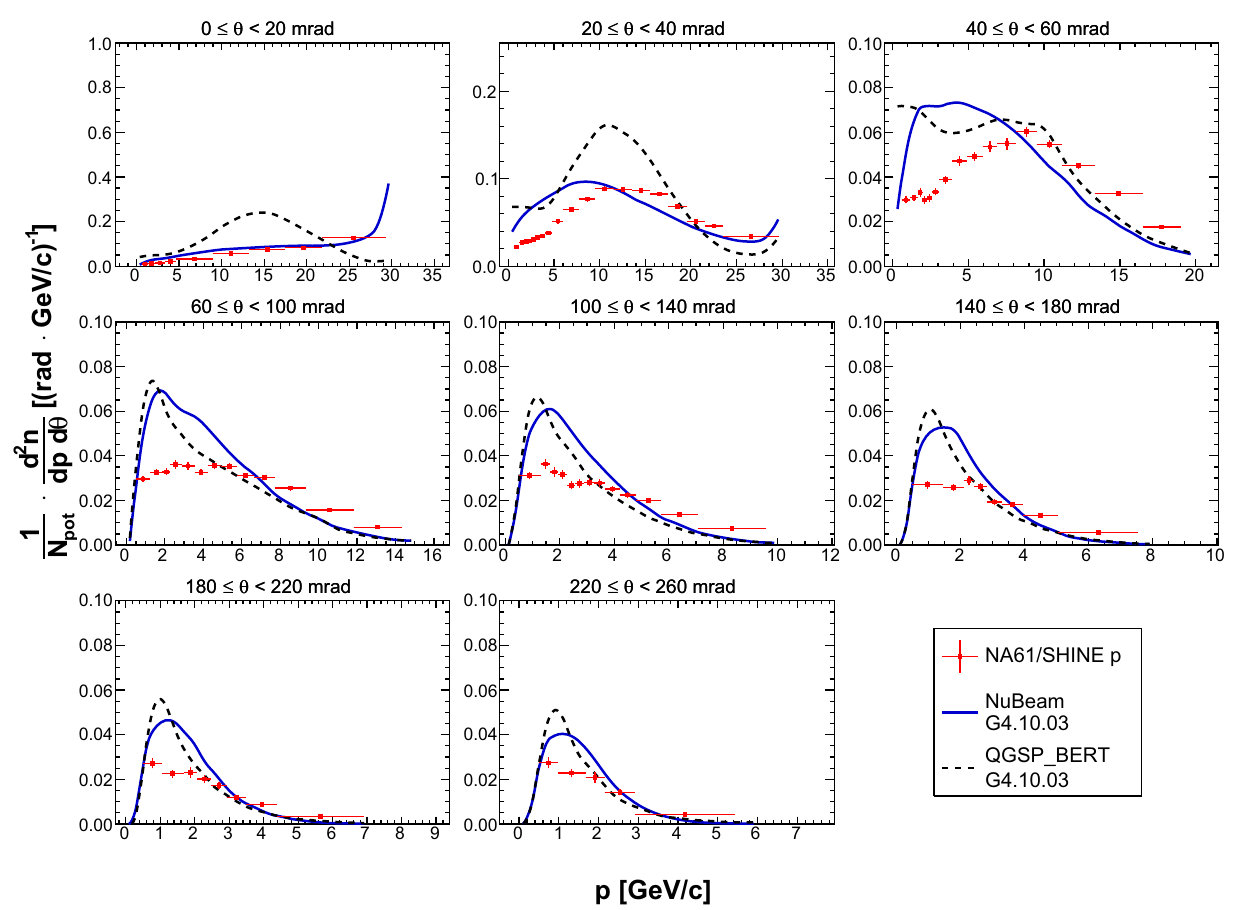
Fig. 52 Double differential yields of protons for the downstream target face ( z = 90cm). Vertical bars represent the total uncertanties. Predictions from the NuBeam (solid blue line) and QGSP_BERT (dashed black line) physics lists from Geant4.10 .03 [27,28] are overlaid on top of the